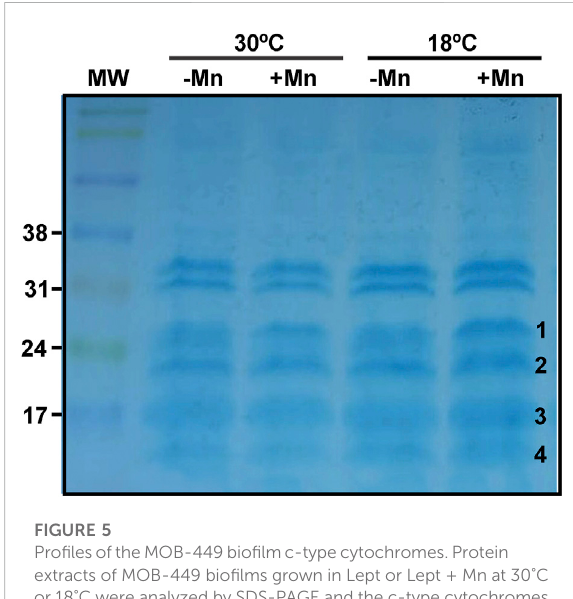
FIGURE 5 Pro fi lesoftheMOB-449bio fi lmc-typecytochromes.Protein extracts of MOB-449 bio fi lms grown in Lept or Lept + Mn at 30 ° C or 18 ° C were analyzed by SDS-PAGE and the c-type cytochromes were revealed via their peroxidase activities using TMBZ staining. Four positive stained and differentially detected bands of proteins were cut-out of the activity gel (numbered at the right of the band) and identi fi ed by MS